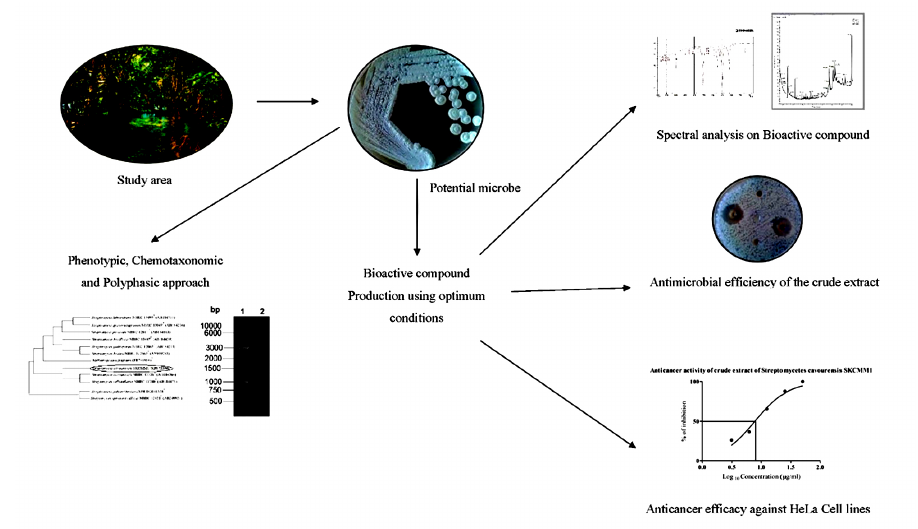
Fig. 1. Schematic representation of the present